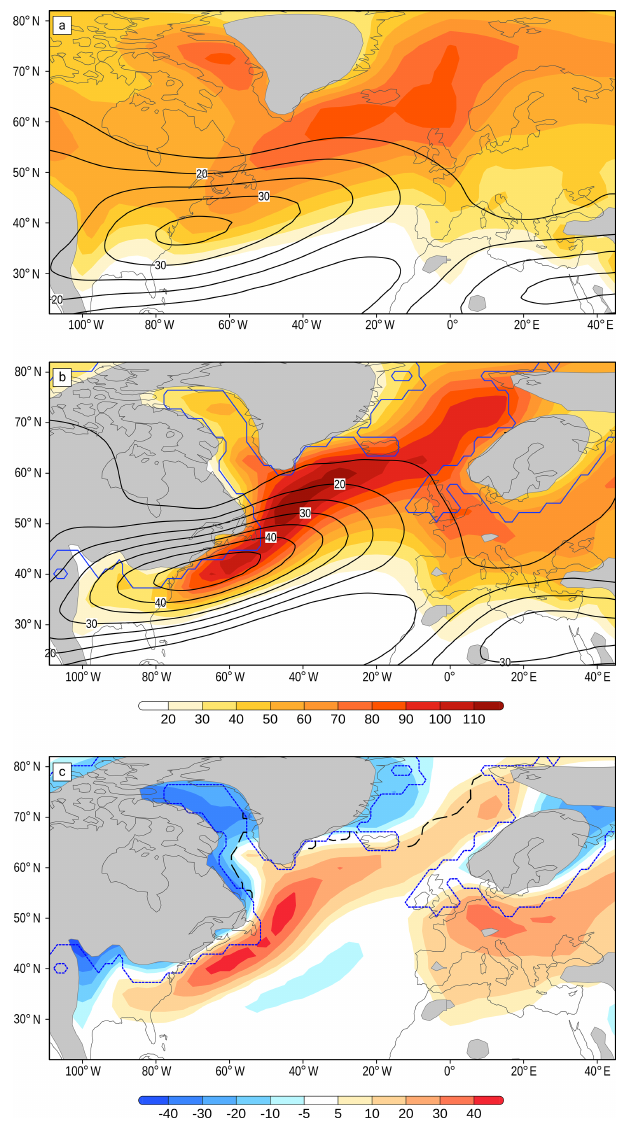
Figure 2. Cyclone track density (cyclone days per extended winter per (deg.lat.) 2 ) (coloured) and 300hPa wind speed (ms − 1 ) (con- tours) based on MPI-ESM-P data for (a) PI, (b) LGM and (c) dif- ference between LGM and PI. Areas with topography higher than 1000m are shaded grey; ice sheet margins (b, c) are denoted by the thin stippled line; the long dashed black line in panel (c) denotes the margin of 40% annual sea ice